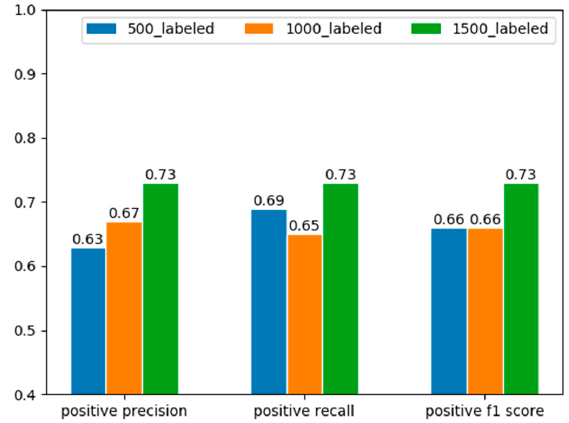
Figure 11. The precision, recall and f1 score of positive samples on the same validation set as the number of labeled samples changes. The results are obtained by randomly selecting part of the total labeled training samples and use the same model and semi-supervised training method.